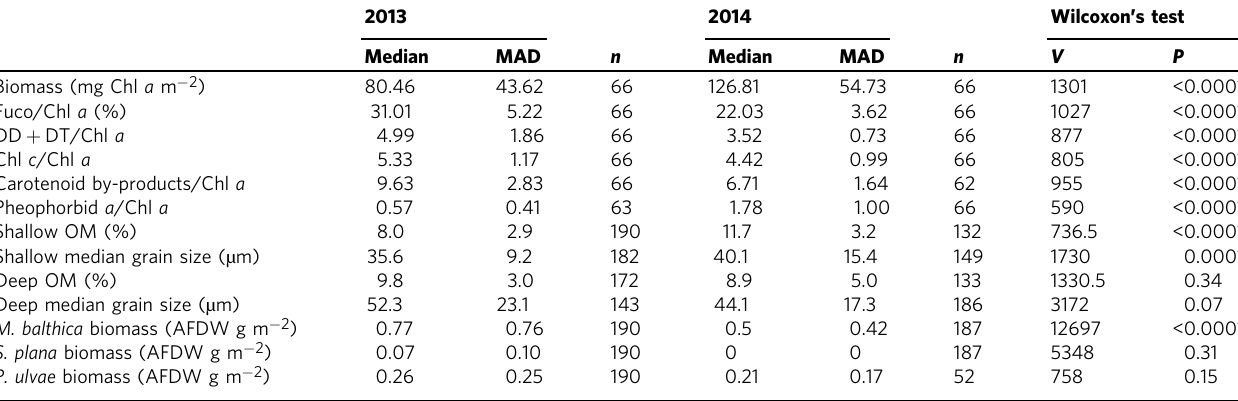
Table 1 Pre- (2013) and post-treatment (2014) MPB biomass, pigment composition and sediment conditions from early